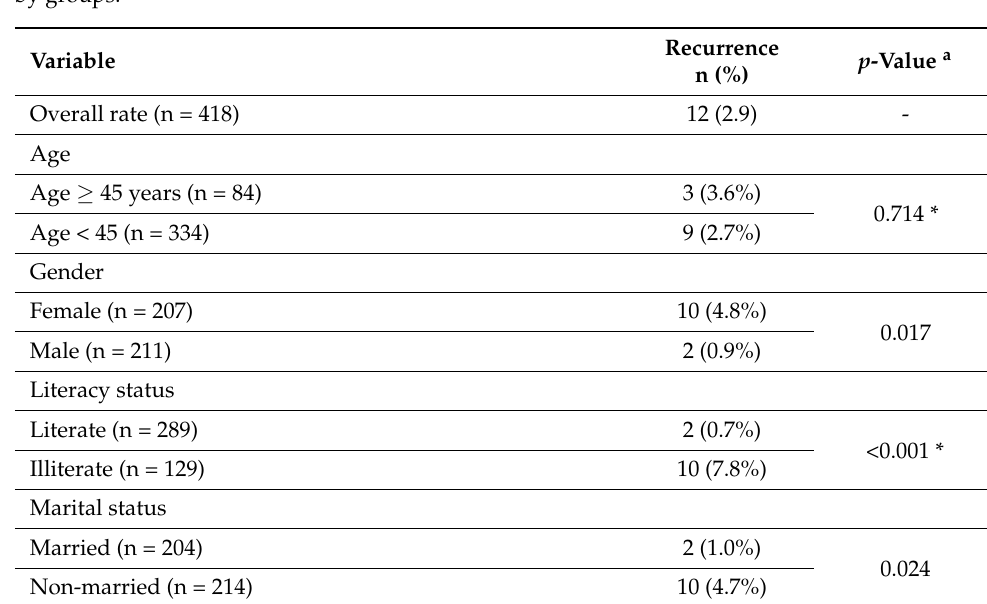
Figure 1. Flowchart of the study. Table 2. Overall, 5-year rate of TB recurrence in the cohort and rates of recurrence in patients stratified by